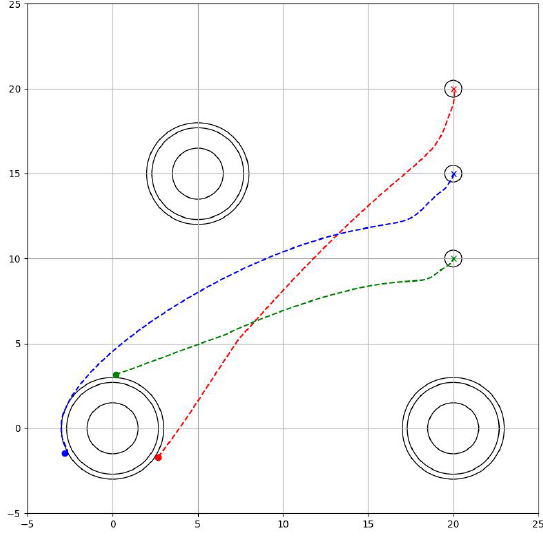
Figure 13. Waiting